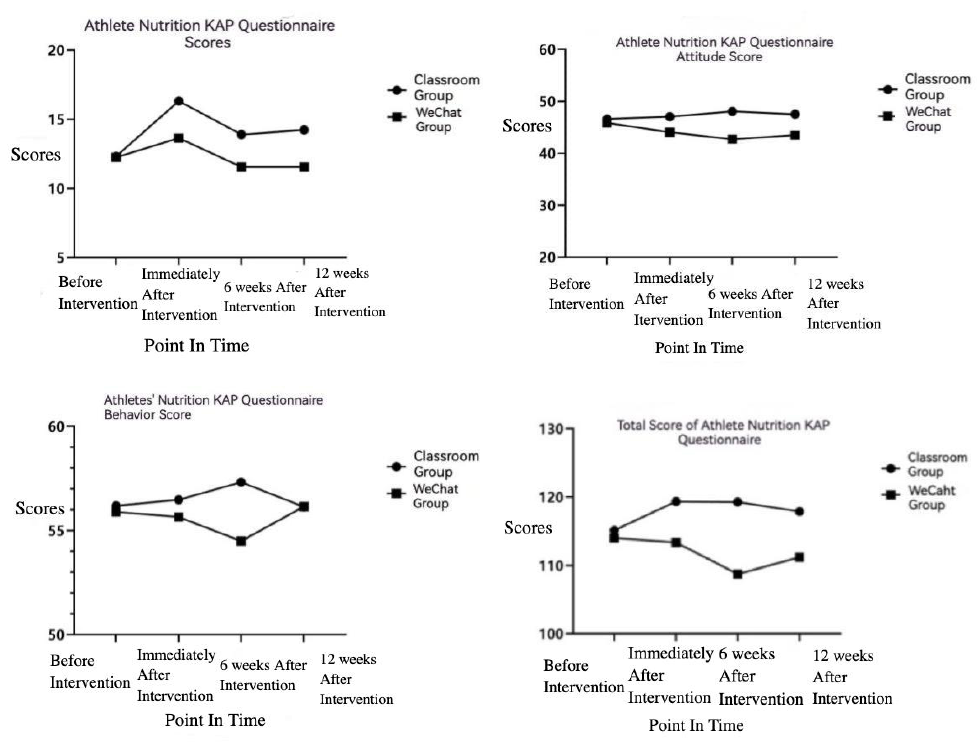
Figure 1. Athlete nutrition KAP questionnaire score trend.